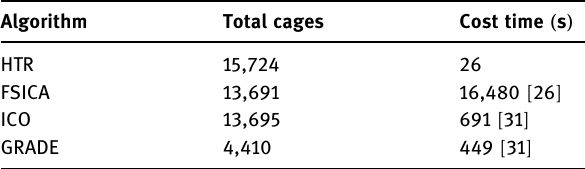
Table 1: In a hydrate system with basically the same number of water molecules, the comparison of the time is required for the four algorithms to identify. Among them, HTR is the data of this work, and the other three sets of data are from other articles